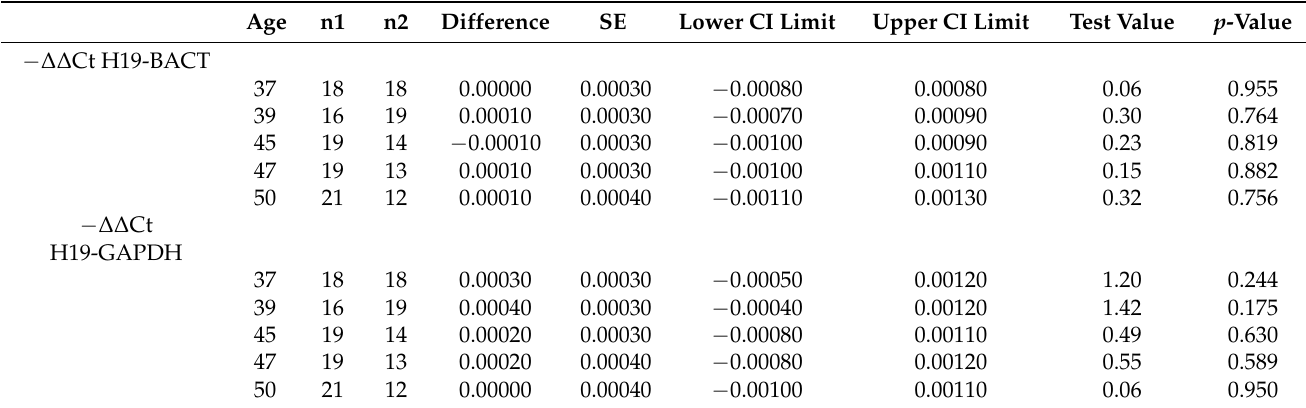
Table 2. H19 expression in acromegaly and control groups taking into account age (nonparametric ANCOVA in R with the WRS2